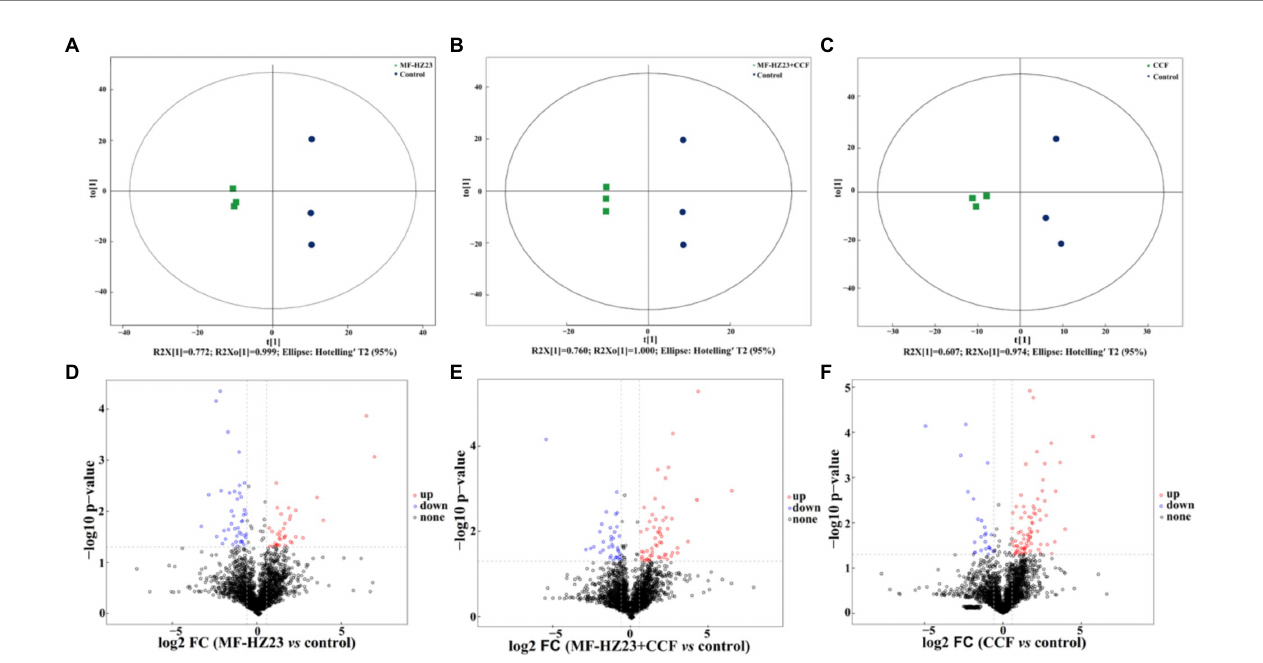
FIGURE 6 Orthogonal partial least squares-discriminant analysis (OPLS-DA) score map of pakchoi rhizosphere soil of the MF-HZ23 (A) , MF-HZ23 plus CCF (B) , and CCF treatment (C) . Volcano plot of differentially accumulated metabolites in MF-HZ23 vs. the control (D) , MF-HZ23 plus CCF vs. the control (E) , and CCF vs. the control (F) . Each point represents a metabolite, blue point indicates metabolities with FC < 0.67 and p < 0.05, red point indicates metabolities with FC ﹥ 1.5 and p < 0.05, black point indicates non-significant